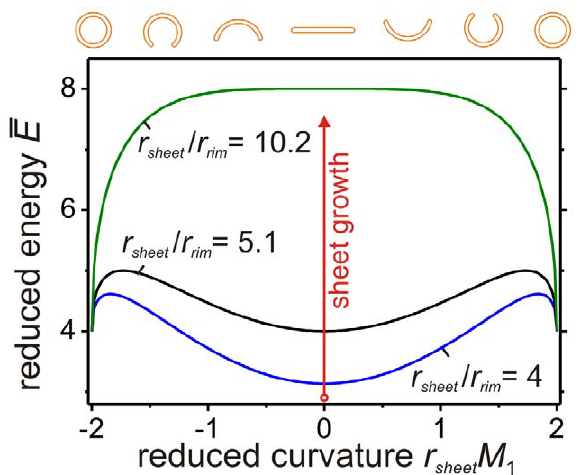
Figure 3. Reduced bending energy of double-membrane shapes, (cid:2) EE , as a function of the reduced curvature r sheet M 1 . The results are calculated for vanishing preferred or spontaneous curvatures m 1 = m 2 = m 3 =0 and vanishing curvature asymmetry m 12 =0; see Equation 8 in Text S1 for the definition of (cid:2) EE . The reduced curvature r sheet M 1 of the cup shapes can be positive or negative, which distinguishes between upward and downward bending of the sheet as schematically illustrated in the top row of the figure. For r sheet / r rim , 5.1 the sheet represents the shape of minimal energy. At r sheet / r rim =5.1 the flat sheet and the closed double-membrane vesicle are local minima with the same energy, but separated by a considerable